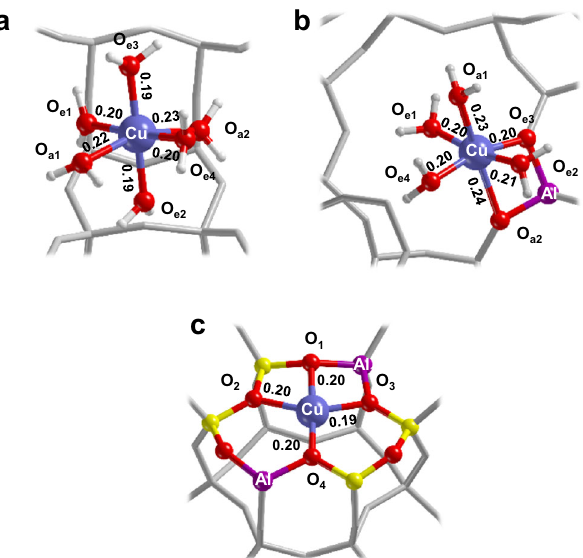
Fig. 6 Atomistic structures of the Cu II interfacial complexes in CHA with (cid:3) @CHA in the composition Si/Al = 15 and Cu/Al = 0.005. a ½ Cu II ð H 2 O Þ 6 ð O (cid:2) 8MR Þ (cid:3) complex and c O Þ Chabazite ’ s largest cage, b ½ Cu II ð H 2 2 4 ½ Cu II O (cid:2) 6MR ð Þ (cid:3) complex at the 2Al-3NN site. Cu – O bond lengths are 4 indicated in nm. The label of relevant nuclei is reported whereas Si and H atoms are shown in yellow and white, respectively. The remaining framework atoms are represented by grey